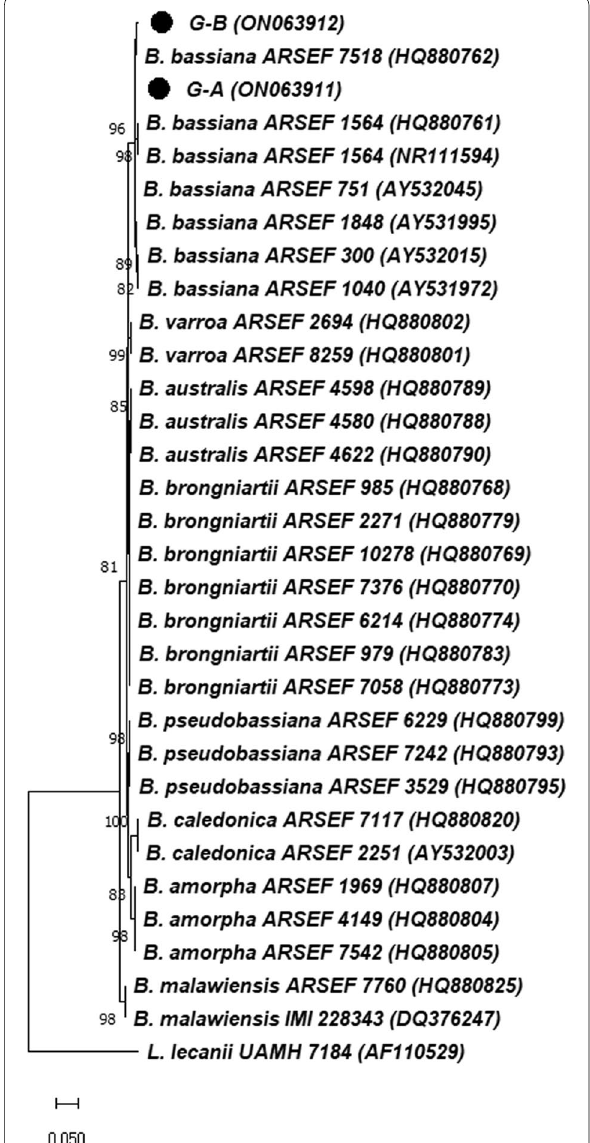
data. Bootstrap tests were conducted with 1000 replicates and neighbor-joining analysis